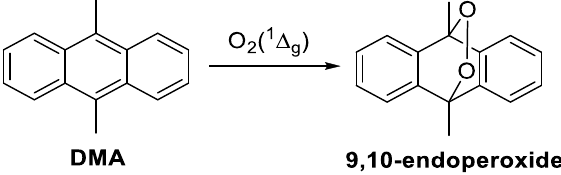
Scheme 3. Photodecomposition of DMA mediated by O 2 ( 1 ∆ g ) to produce